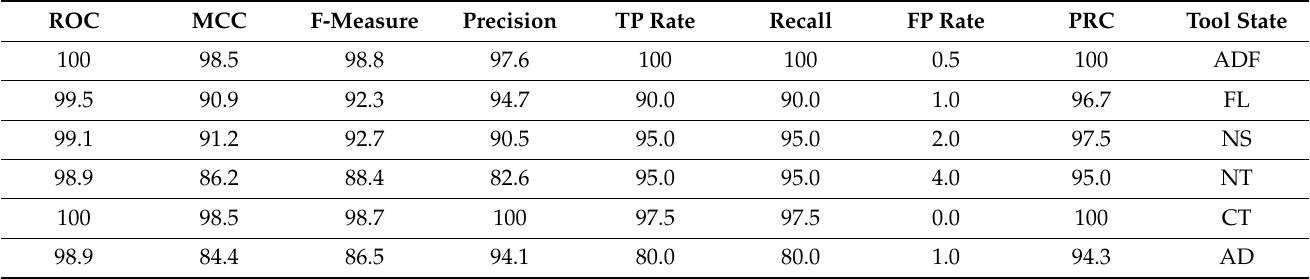
Table 3. Performance indicators of classification considering cross-validation mode.